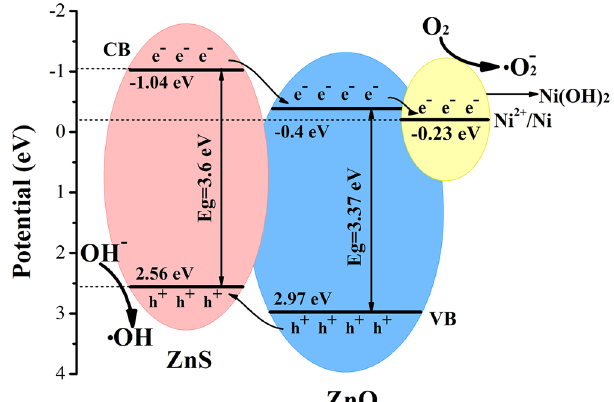
Figure 8. Schematic illustration for photodegradation mechanism, and the charge transfer and separation in the NZZN under UV-vis light